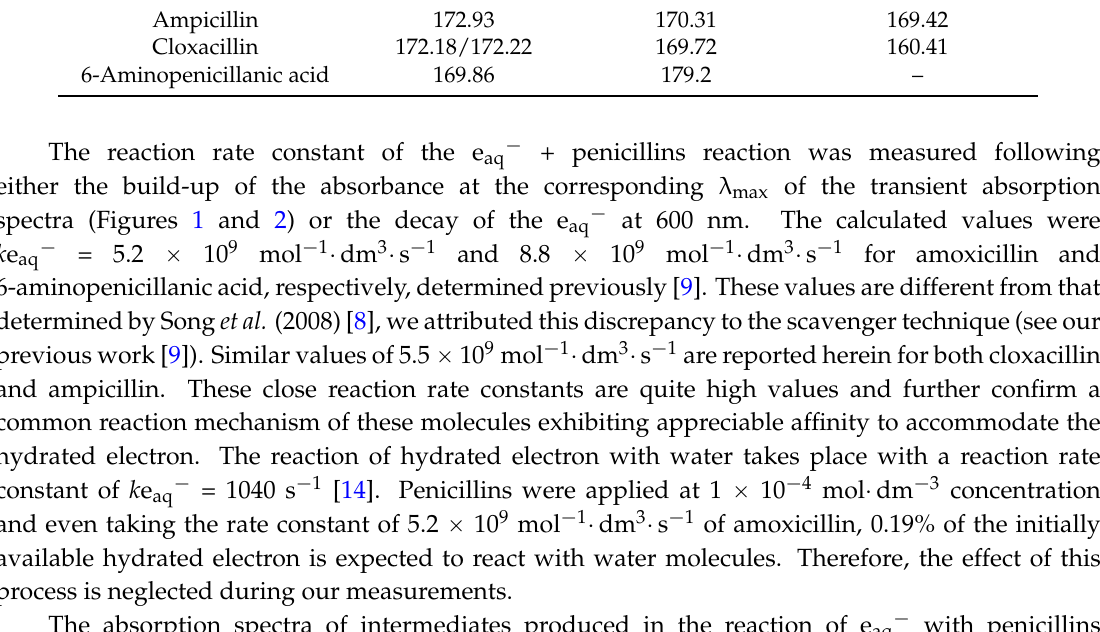
Table 1. 13 C NMR characteristics of penicillins.